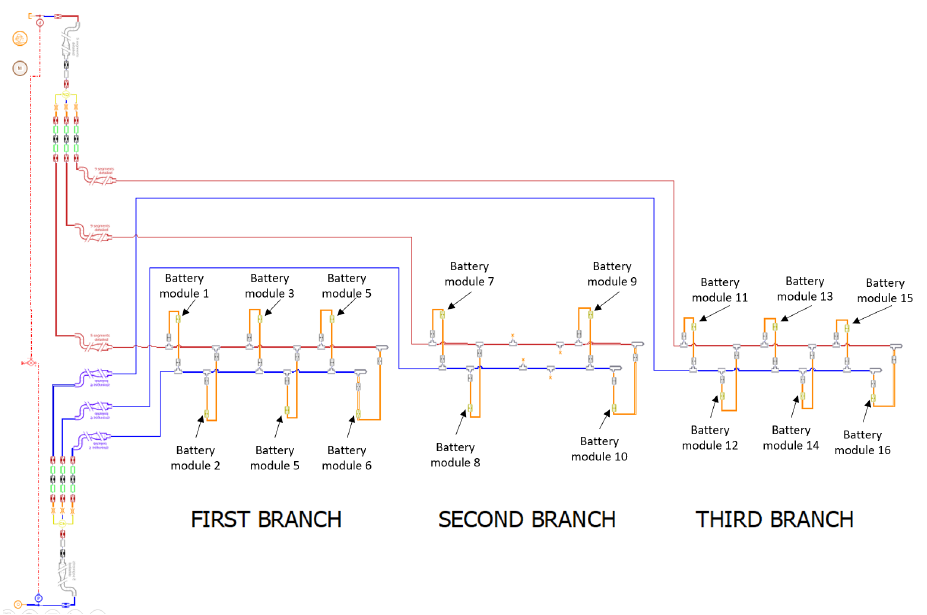
Figure 11. Numerical model with battery modules.